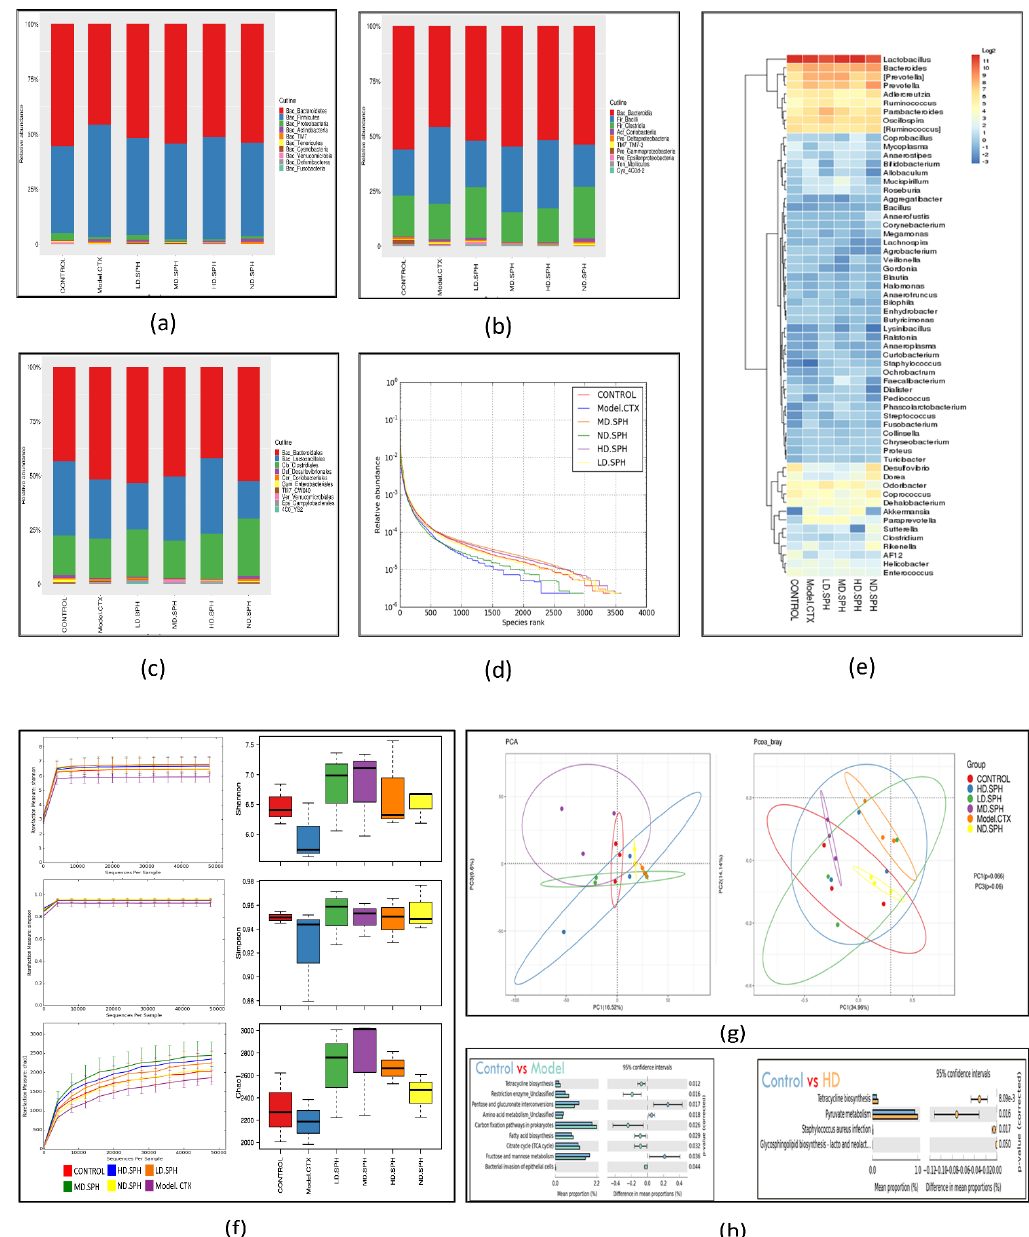
Figure 10. SPH’s impacts on the gastrointestinal microbiota at the molecular basis. ( a – c ) Individual samples at the taxonomic levels of phylum, class, and family. ( d ) A rank abundance curve depicts the richness and evenness of the species. The x- and y-axes depict the number of operational taxonomic units based on the distribution, abundance, and abundance of each species (OTUs). ( e ) Hierarchical clustering of gut microbiome via heat map analysis of the highly characterized bacterial taxa genus level. ( f ) Rarefaction curves depicting species diversity and abundance. For each treatment group, the Shannon, Simpson, choa1 alpha coefficient depicts the microbial richness and diversity. ( g ) The proportion of the mice stool specimens predicated on the evolutionary appearance of their intestinal bacteria is shown in a principal coordinate analysis (PCoA) plot with Bray–Curtis dissimilarity. Every specimen is depicted by a dot in the graph, with various colors representing a diverse experimental group ( n = 3). The deviation between the observations is represented by the range among each other; the nearer the specimens are, the more differently compared they are. ( h ) Analysis of functional genes associated pathways in the control, Model-CTX, and treated